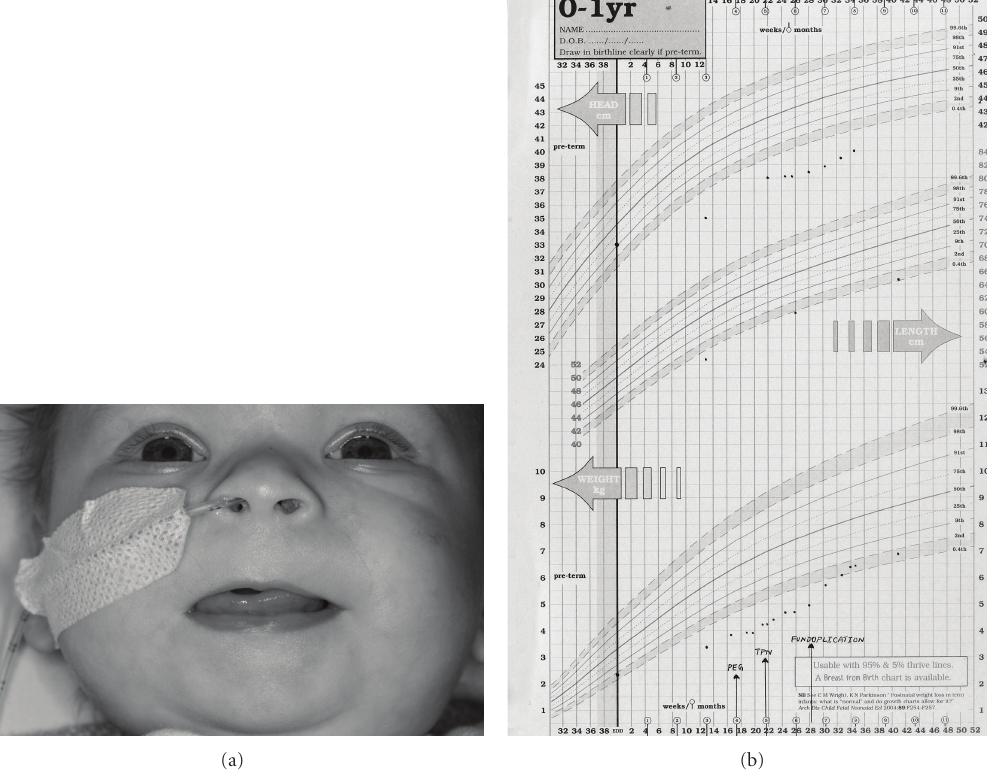
Figure 1: (a) Foetal alcoholic syndrome: face, note the short palpebral fissures, flat nasal bridge and small nose, strikingly featureless philtrum and poorly formed upper lip. (b) Severe malnutrition and growth restriction in foetal alcoholic syndrome. Initially all treatments failed to establish adequate nutrition and growth, including insertion of a gastrostomy and total parenteral nutrition, due to persistent severe vomiting. After 6 months of age, a fundoplication was performed, and gradually enteral nutrition could be reestablished. The child has caught up weight and growth into the percentiles but is still dependent on gastrostomy feeding at present (4 years and 10 months of age).